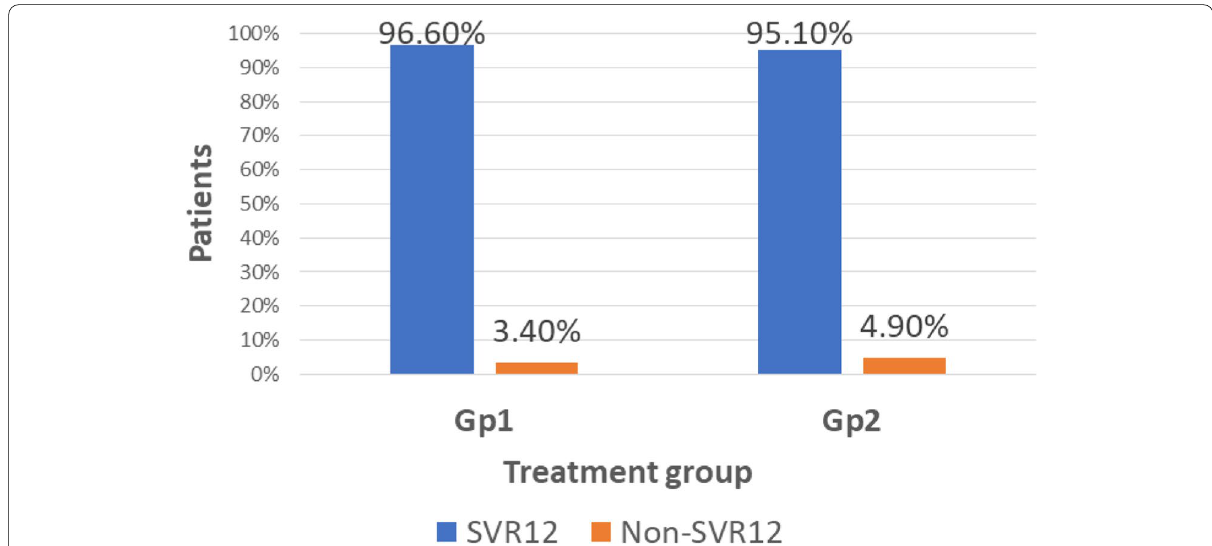
Fig. 2 Comparable percentages of patients who achieved SVR 12 in Gp1 and Gp2. SVR 12 , sustained virological response; Gp, treatment group. Gp1 received sofosbuvir 400 mg/day plus daclatasvir 60 mg/day plus simeprevir 150 mg/day plus ribavirin 15 mg/kg/day for 12 weeks. Gp2